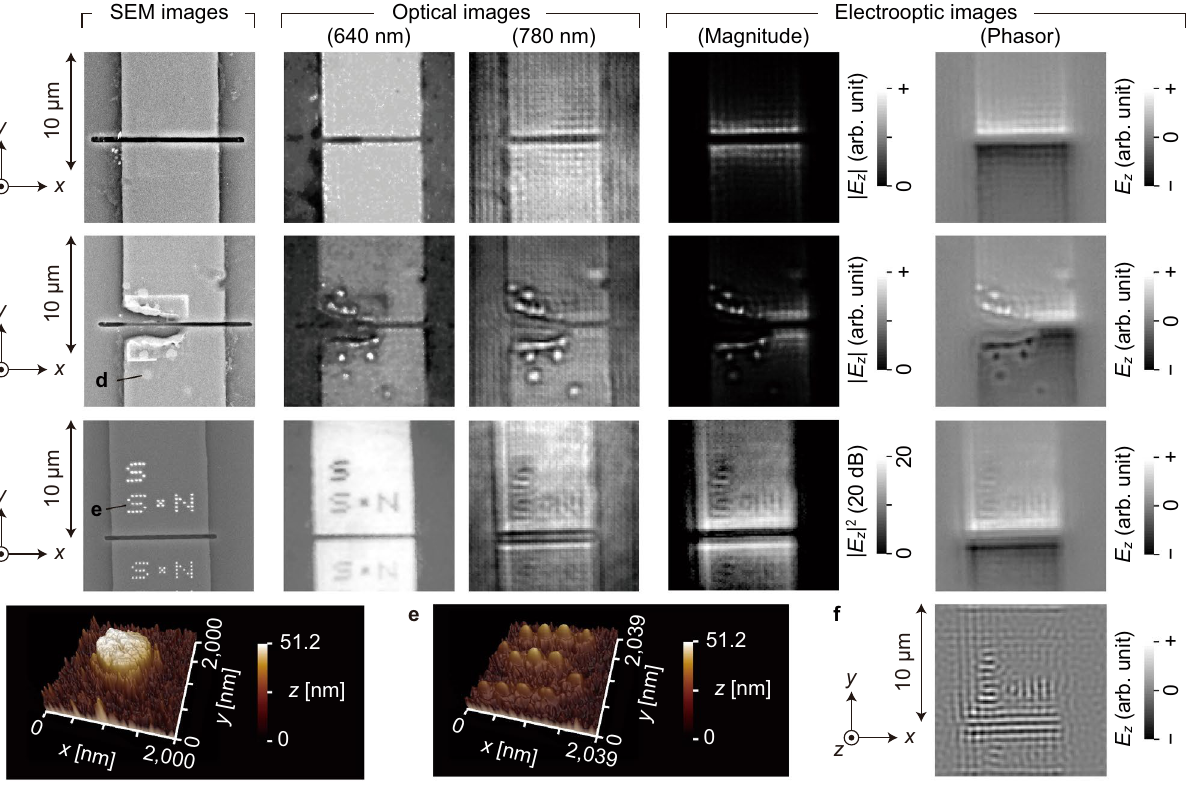
Figure 3. Electric field images for electrode patterns with nanometre-scale gaps. SEM and optical images are also included. ( a ) Simple 320 nm gap (pattern A). (b) Broken 270 nm gap (pattern B). ( c ) Gap with arrays of synthesized nanometre dots (pattern C). AFM images ( d ) and ( e ) are for the dots in ( b ) and ( c ), respectively. ( f ) Phasor image generated by the DEI